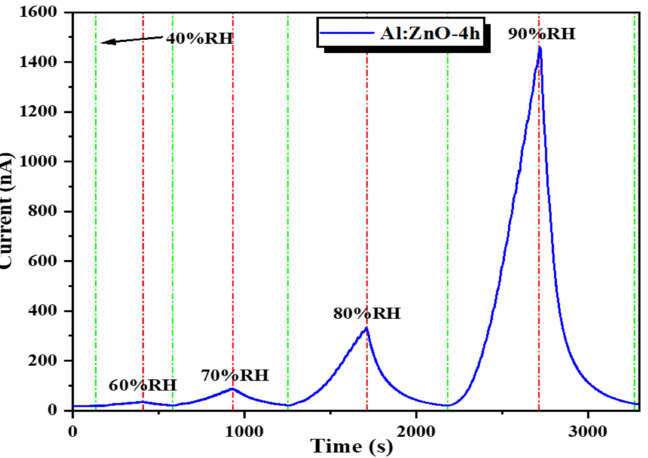
Figure 18. Humidity-sensing response of the Al:ZnO-4 h nanostructured-based flexible humidity sensor at various relative humidity